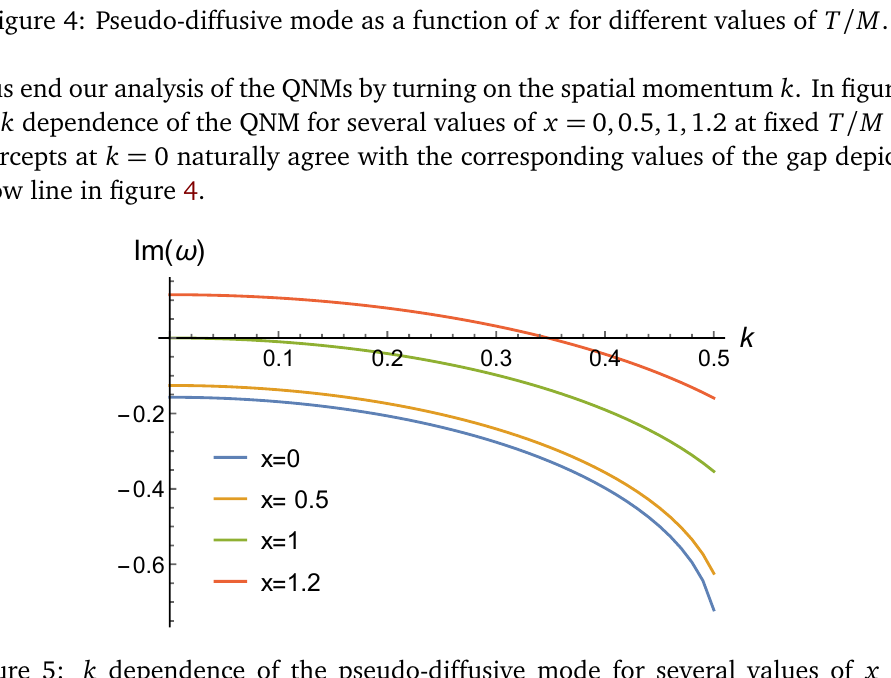
Figure 5: k dependence of the pseudo-diffusive mode for several values of x at T / M = 1 /